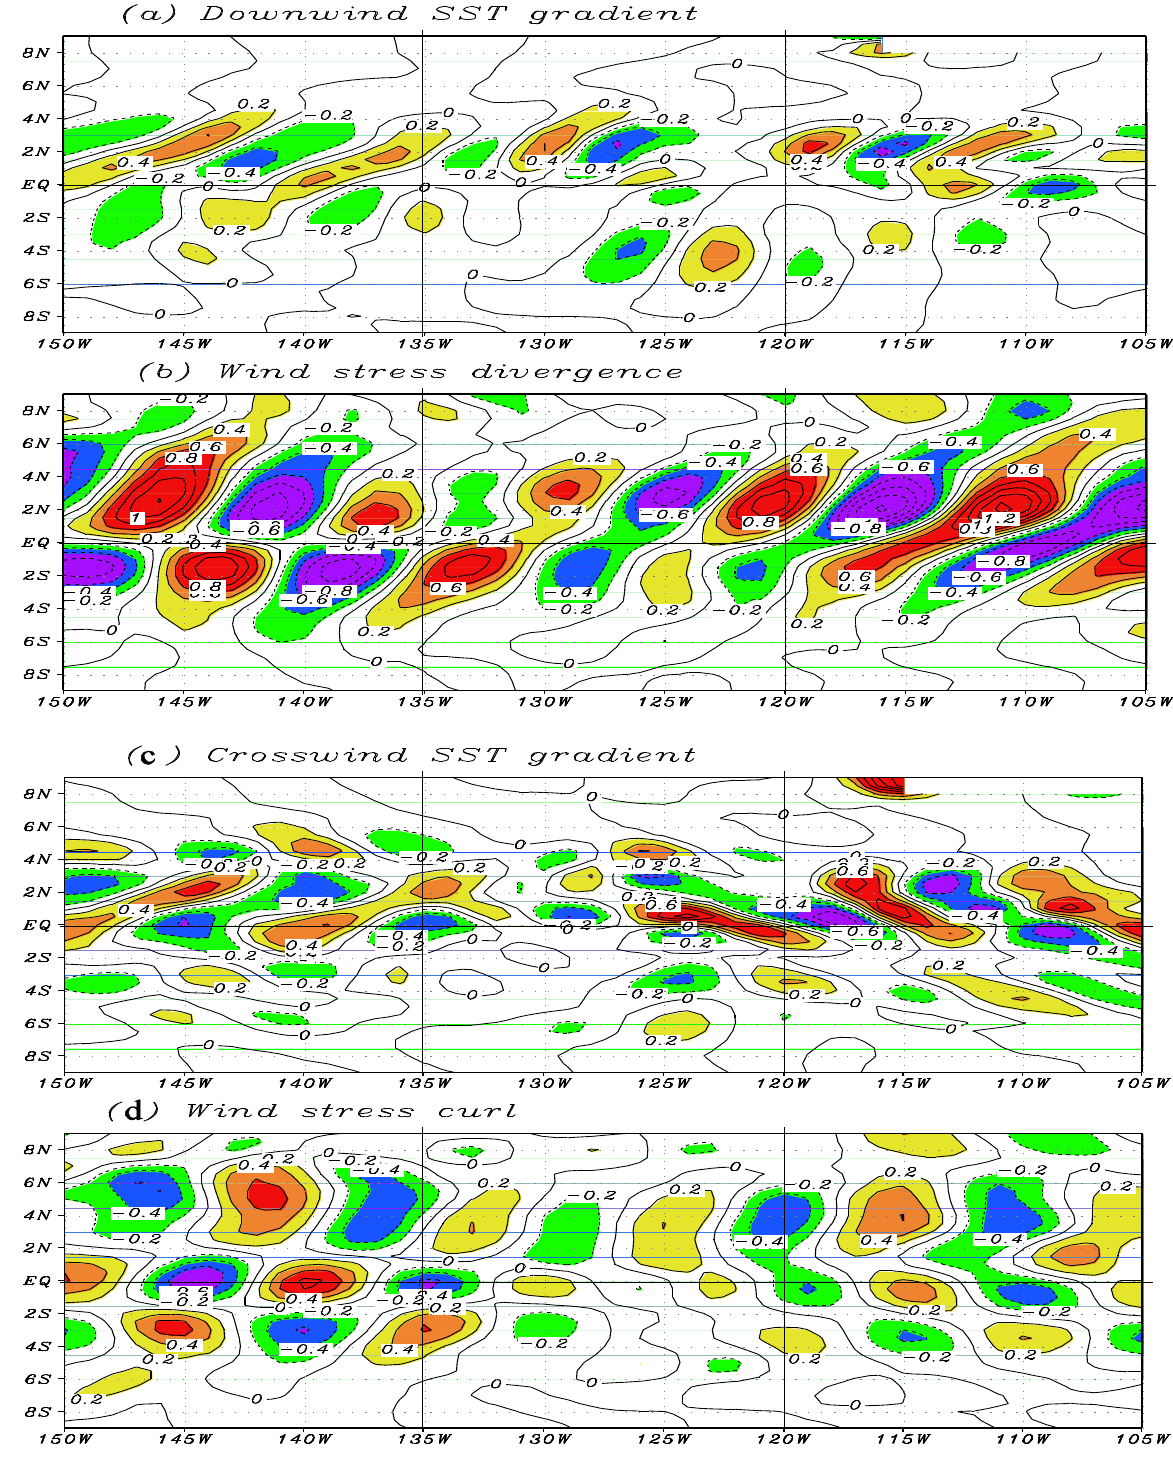
Figure 9. Examples of the horizontal patterns on 1 October, calculated from the reference feedback run: ( a ) the downwind component of the SST gradient; ( b ) the wind stress divergence; ( c ) the crosswind component of the SST gradient; and ( d ) the wind stress curl, respectively. The contour is 0.2 °C per 100 km in (a,c), and is 0.2 N·m −2 per 10 4 km in